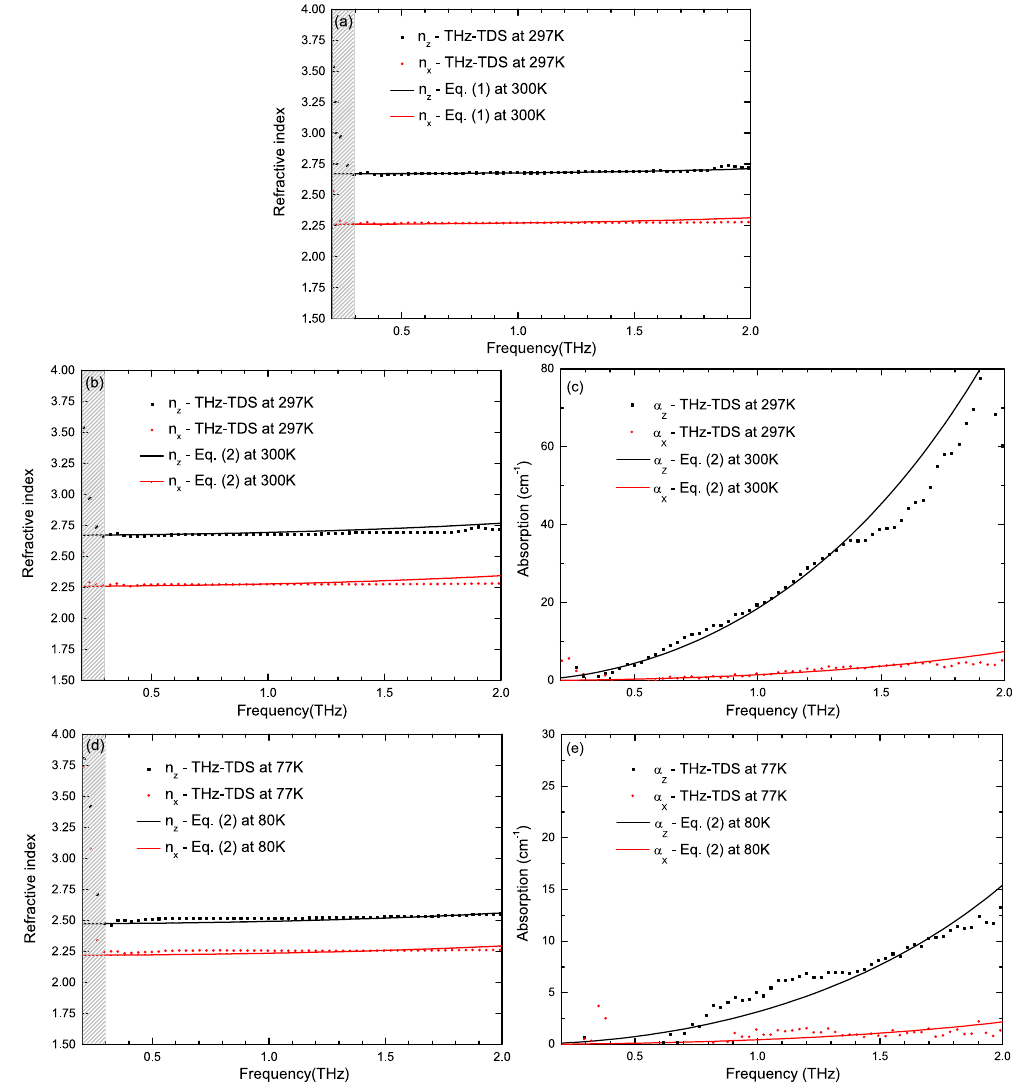
Figure 3. ( a ) Experimental results n Z (black solid square) and n X (red solid circle) from 0.2 to 2.0 THz at 297 K; Fitting results of n Z (black line) and n X (red line) from 0.2 to 2.0 THz at 300 K based on Eq. (1). ( b , d ) Experimental results n Z (black solid square) and n X (red solid circle) from 0.2 to 2.0 THz at 297 K and 77 K, respectively; Fitting results n Z (black line) and n X (red line) from 0.2 to 2.0 THz based on Eq. (2) at 300 K and 80 K, respectively. ( c , e ) Experimental results α Z (black solid square) and α X (red solid circle) from 0.2 to 2.0 THz at 297 K and 77 K; Fitting results α Z (black line) and α X (red line) from 0.2 to 2.0 THz based on Eq. (2) at 300 K and 80 K,